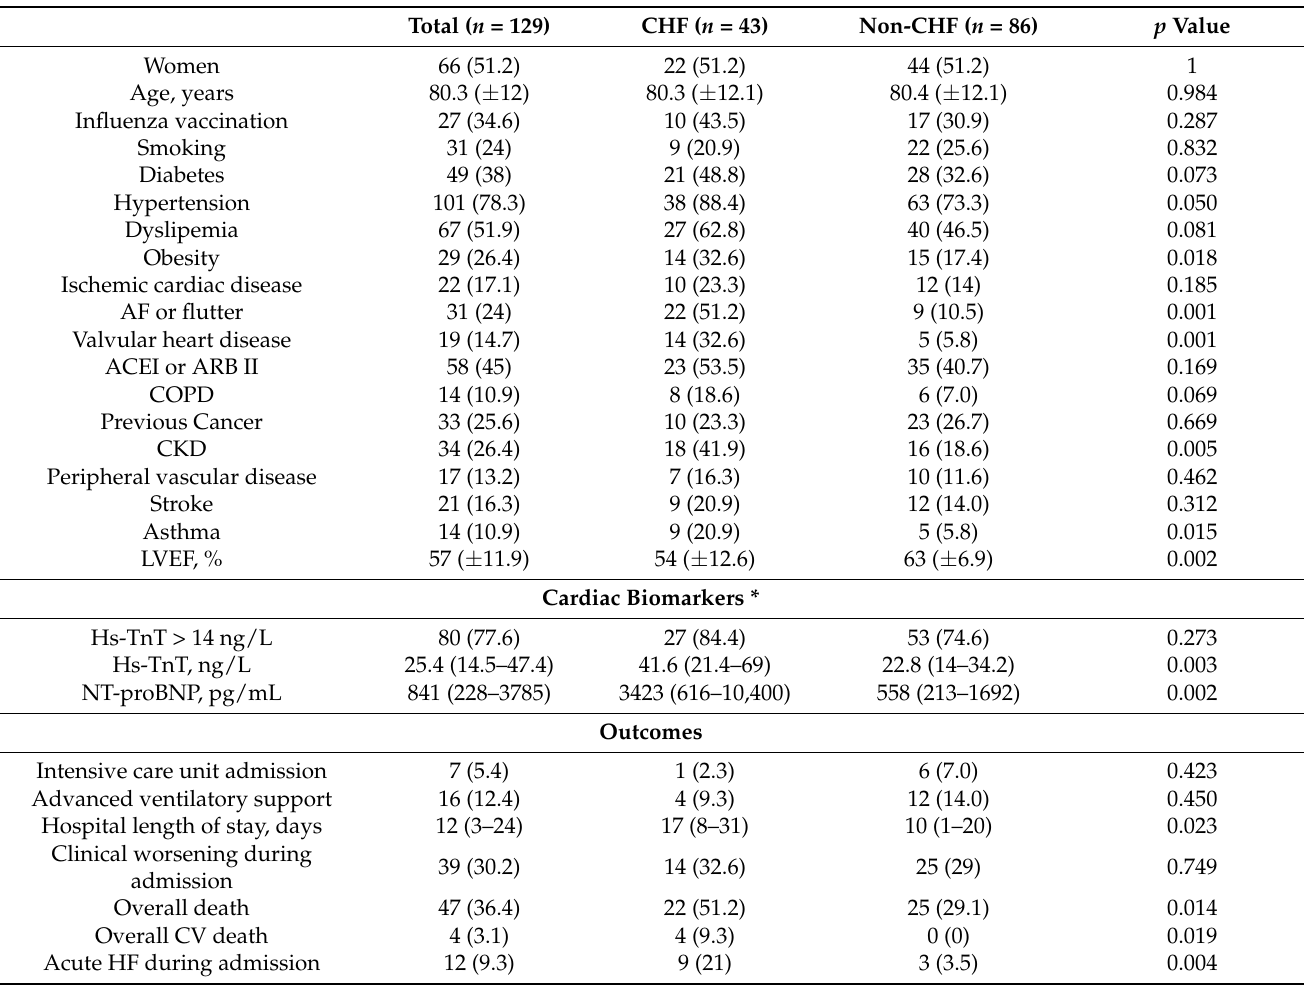
Table 1. Comparison of baseline characteristics and outcomes between patients with and without chronic heart failure